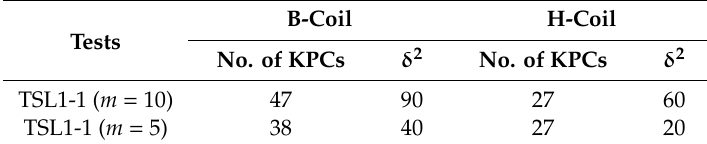
Table 3. Estimated parameters when m = 10 and m = 5.